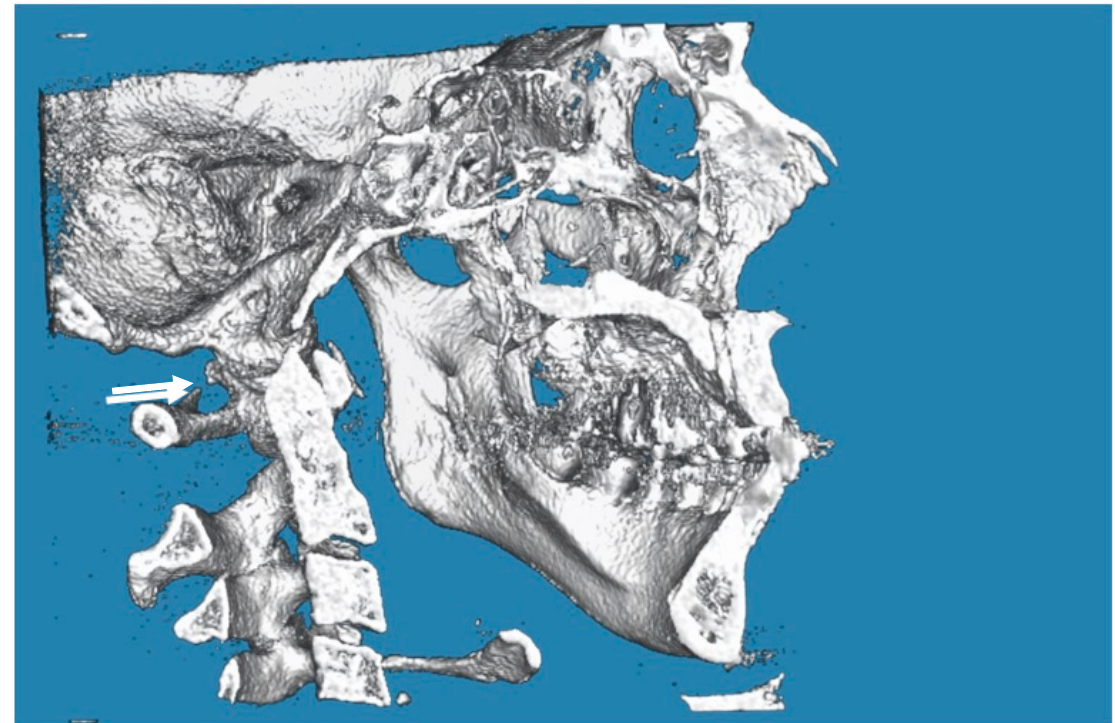
Figure 4. CBCT image of the partial PP on the left (indicated by the arrow). The image is taken from the “G. D’Annunzio” University archives.